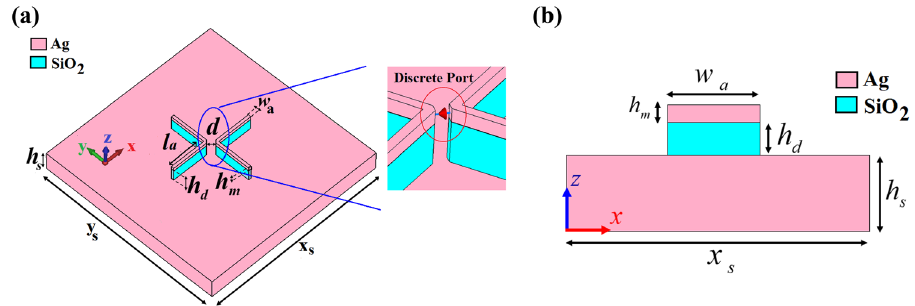
Figure 1. ( a ) The 3D perspective and ( b ) cross-section views of cross dipole nano-antenna without the director with 3D zoom in to show the discrete source as an illumination port. The thickness of substrate and foot-print are h s = 220 nm and x s × y s = 3500 × 3500 nm 2 ,